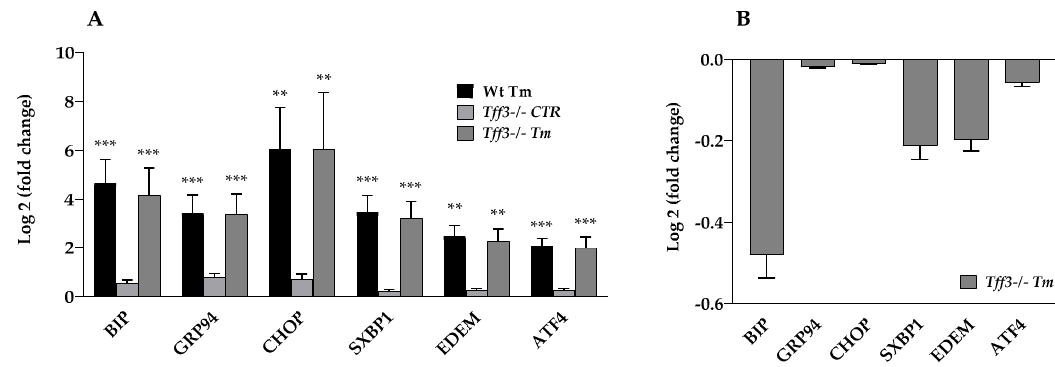
Figure 1. E ff ect of tunicamycin treatment on the expression of ER stress markers. We performed a quantitative polymerase chain reaction (qPCR) using SYBR green detection chemistry for each group ( n = 5 animals per group), wherein C t data were analyzed by REST software and presented relative to the Wt control group as log 2 (fold change) ( A ). Additionally, expression of genes in tunicamycin-treated trefoilfactorfamily3( T ff 3 ) − / − micewasexpressedrelativetoWttunicamycin-treatedmice( B ).** p ≤ 0.01, *** p ≤ 0.001; Wt Tm = wild type tunicamycin-treated mice, T ff 3 − / − CTR = T ff 3 -deficient untreated mice, T ff 3 − / − Tm = T ff 3 − / − tunicamycin-treated